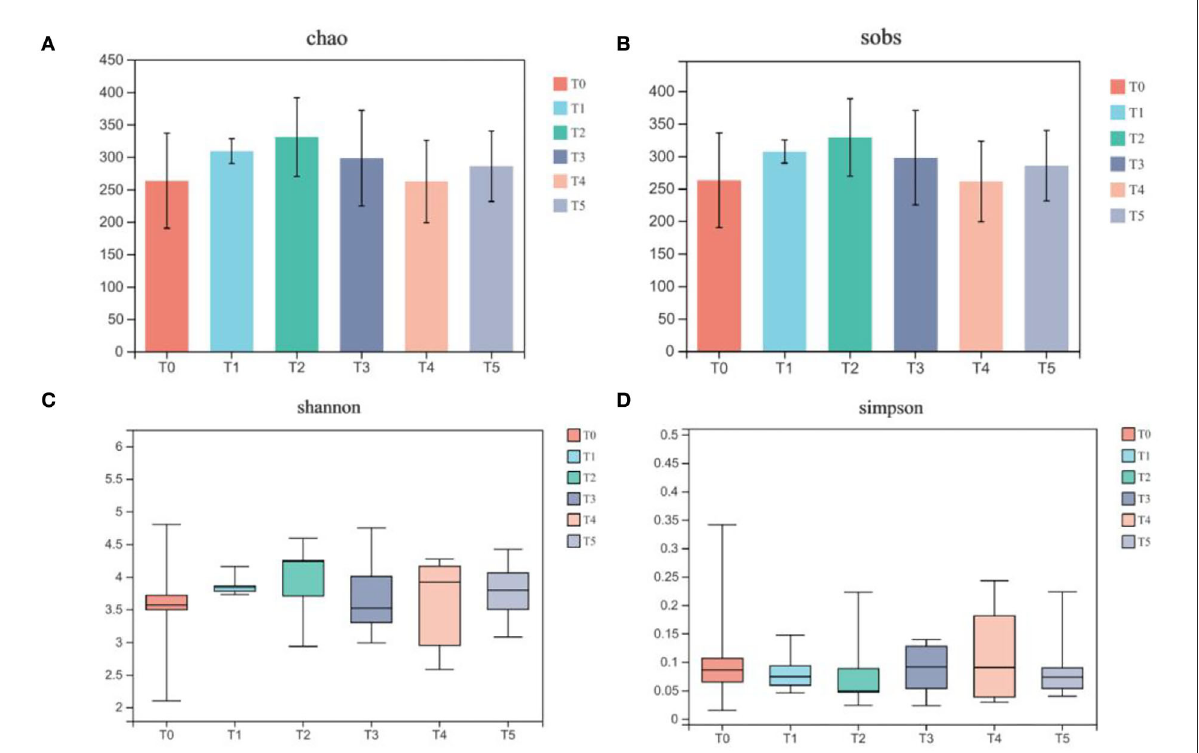
FIGURE6 Dietary supplementation of CAP affects the alpha diversity of gut microbiota in Cobb broilers ( n = 6). (A) Chao; (B) sobs; (C) Shannon; (D) Simpson. Multiple comparisons were determined by one-way analysis of varlance (one-way ANOVA), followed by Tukey-Kramer as a post hoc test. T0: fed diets based on SBM as the only protein source; T1, T2, T3, T4, T5: 1, 2, 3, 4, and 5% of CAP were added.